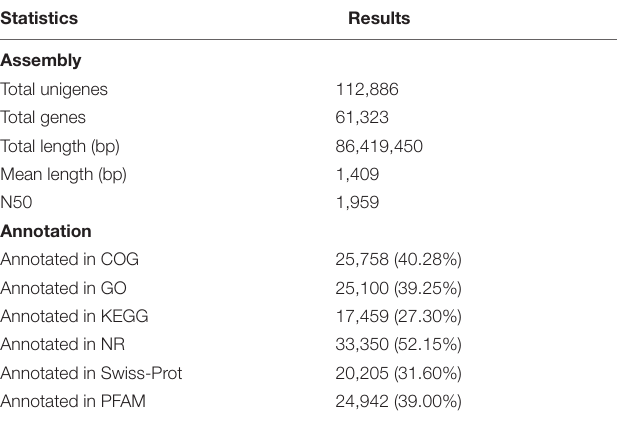
TABLE 3 | The de novo transcriptome assembly and annotation results of unigenes in public protein